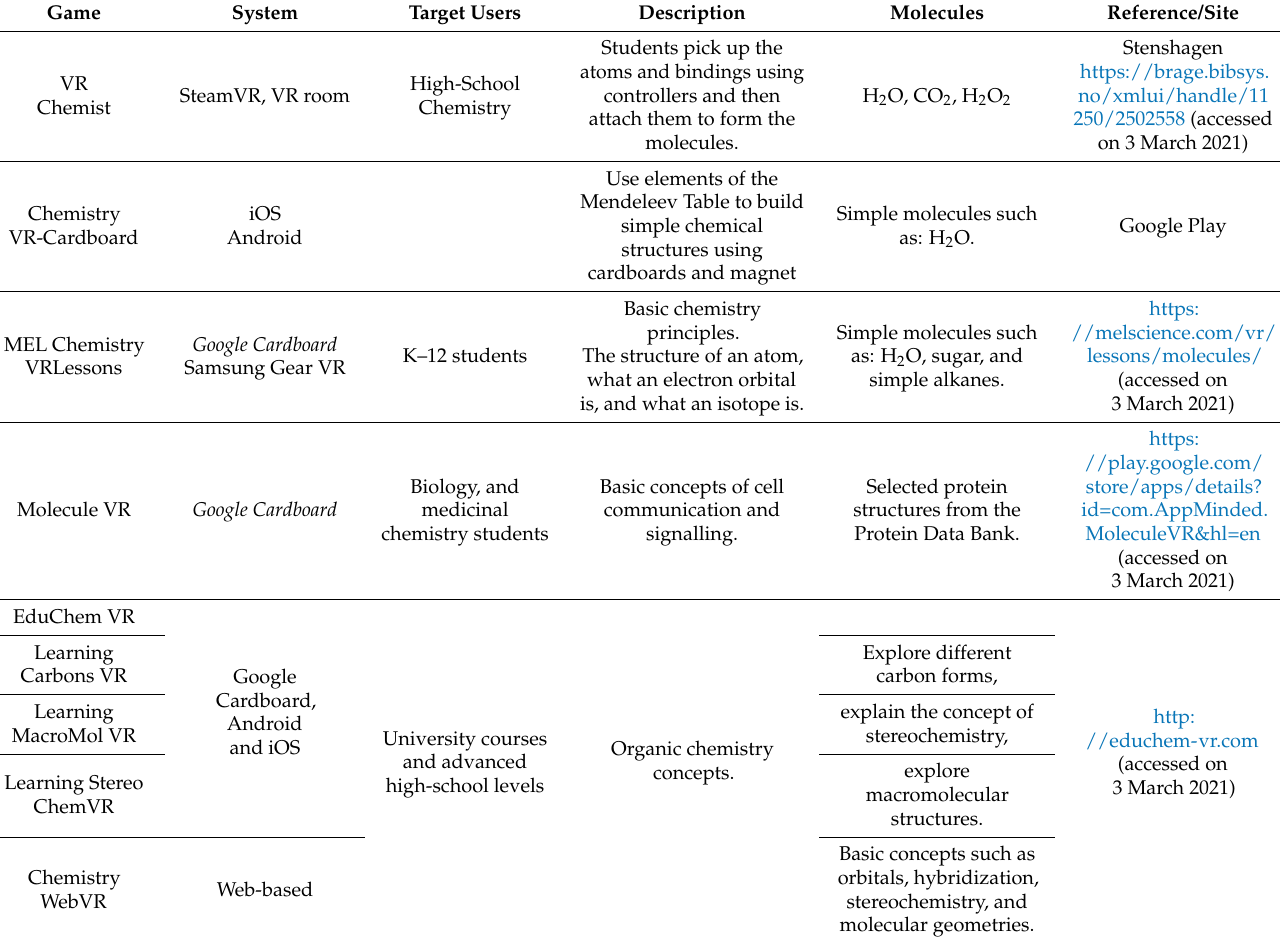
Table 1. Current VR educational applications for